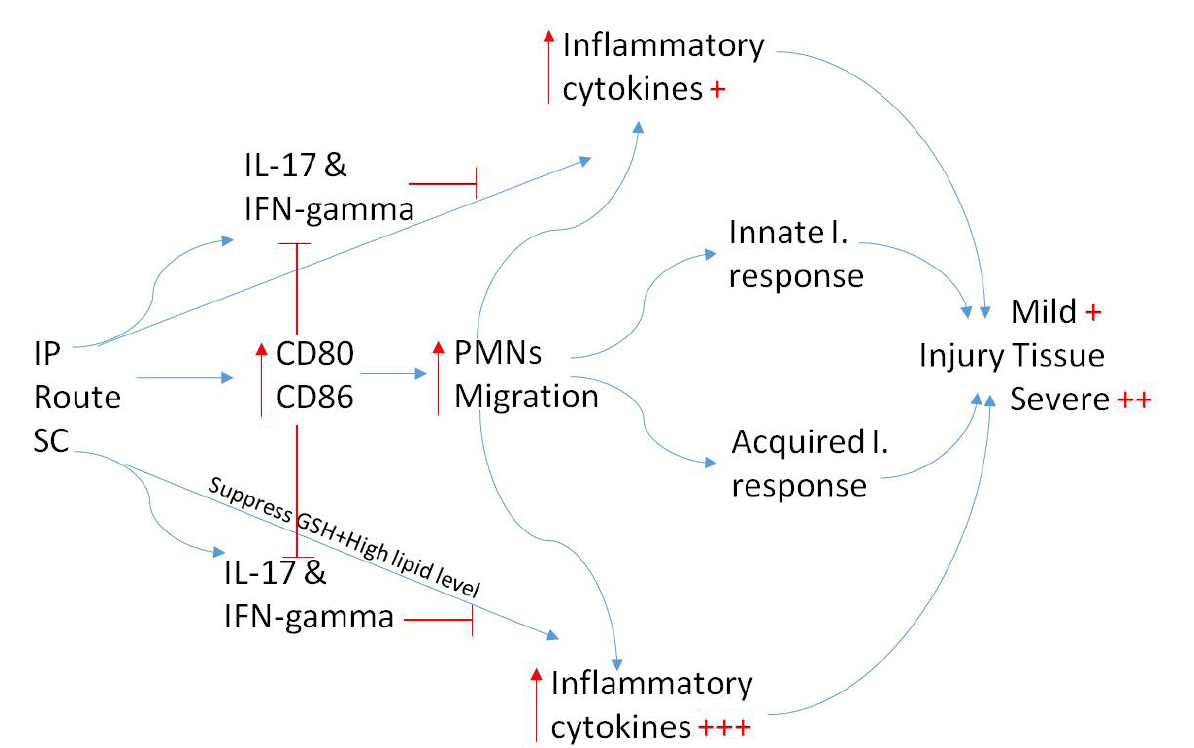
Figure 9. A summary of the effect of the two injection routes, intraperitoneal (IP) and subcutaneous (SC). Both IP and SC injections upregulate the expression of CD80 and CD86 on the PMNs (red arrows), and this directly support migration. Inflammatory cells increase cytokine secretion. By supressing GSH and elevating lipogram, SC was found to enhance tissue damge, (++) and this may be due to increase inflammatory cytokines (+++). Results showed that upregulation of the expression of CD80 and CD86 did not affect IL-17 and IFN-γ in SC rats (blocked line) and it was associated with a remarkably decrease of these two cytokins in IP